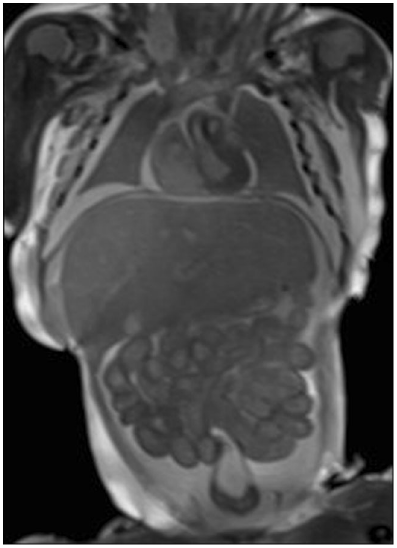
Fig. 2 Coronal T2-W image of a 25 weeks fetus in a case of intrauterine death. There is bilateral pleural effusion, subcutaneous edema, ascitis, distended bowel loops, and enlarged appearance of the normal fetal liver. All findings are physiological postmortem